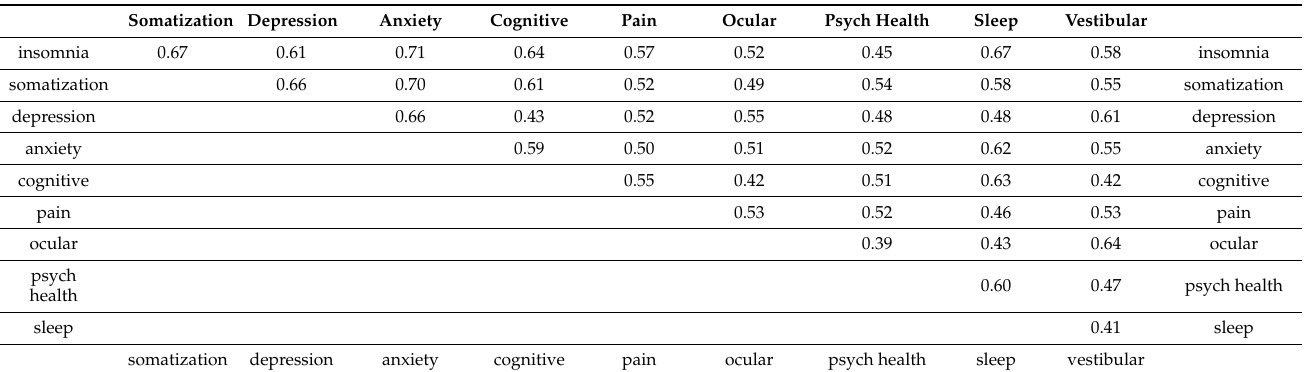
Table 1. Coincidence rates at baseline ( n = 62) for pairs of symptoms and adjudicated clinical syndromes. Clinical syndrome names are highlighted in gray. See text for details. Insomnia threshold score = 15 (ISI). Somatization, depression, and anxiety threshold t-statistic = 63 (BSI). The six clinical syndromes were assessed by consensus at